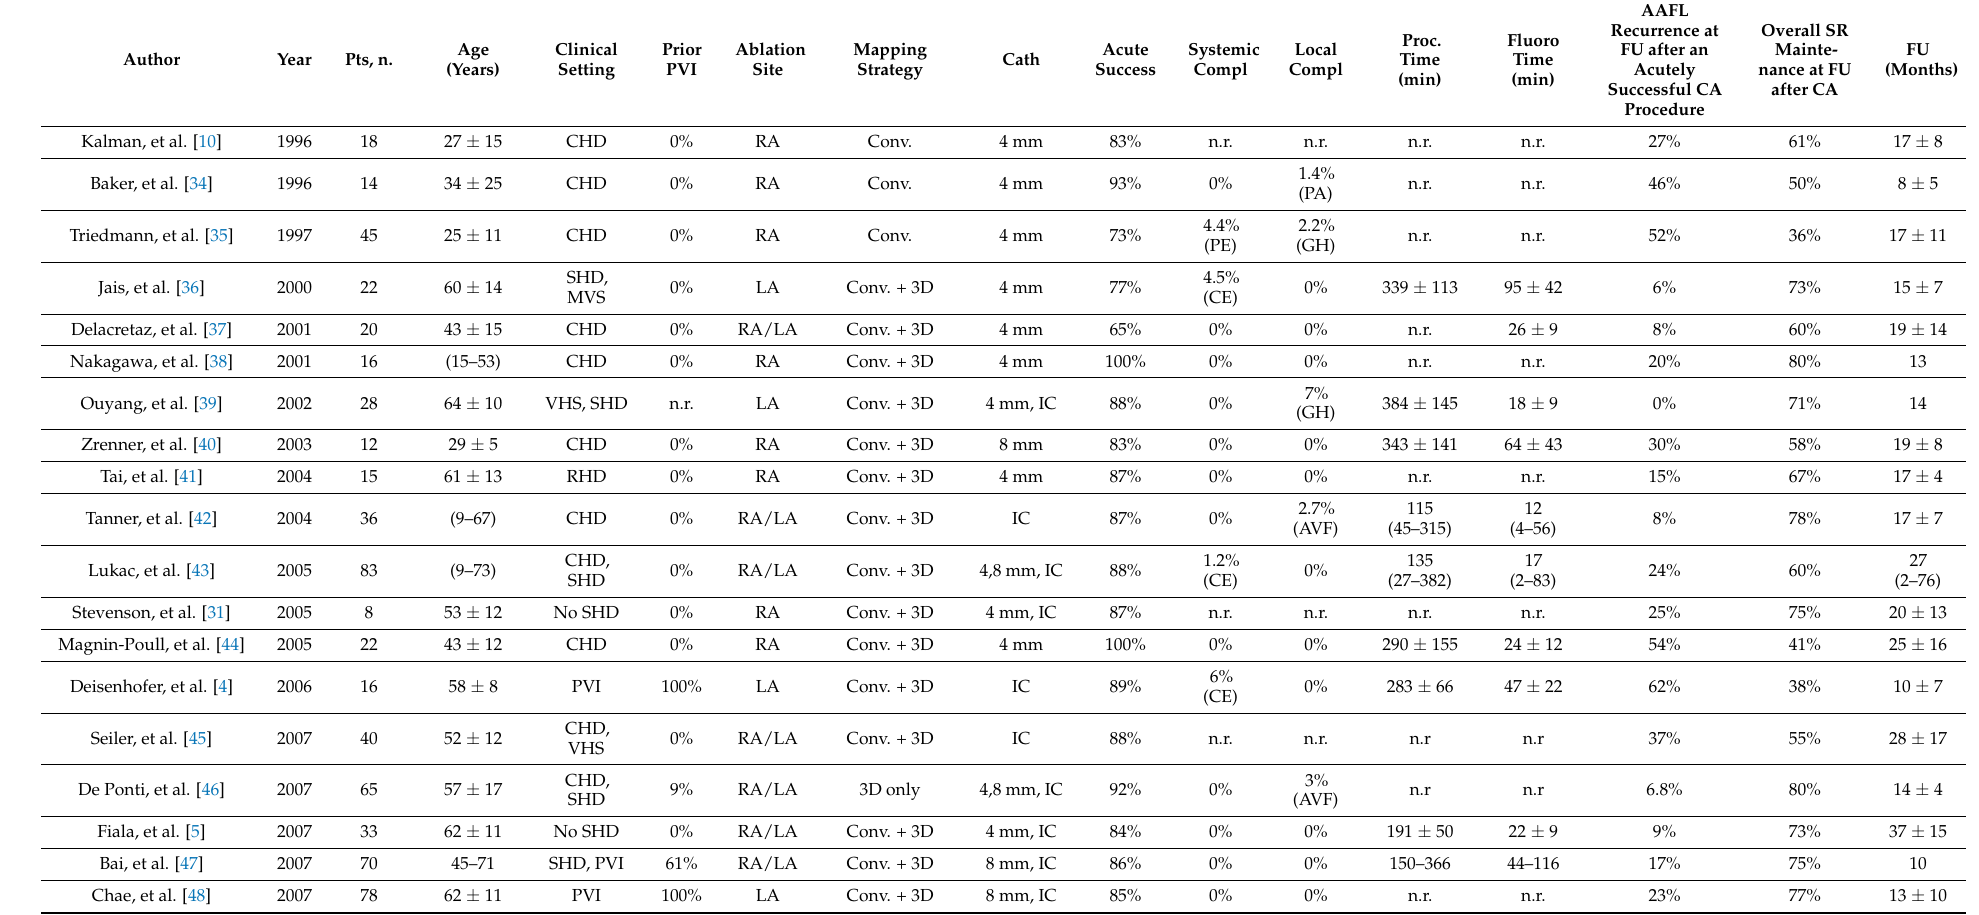
Table 1. Review of current literature on the feasibility of catheter ablation of atypical atrial flutters in different patient